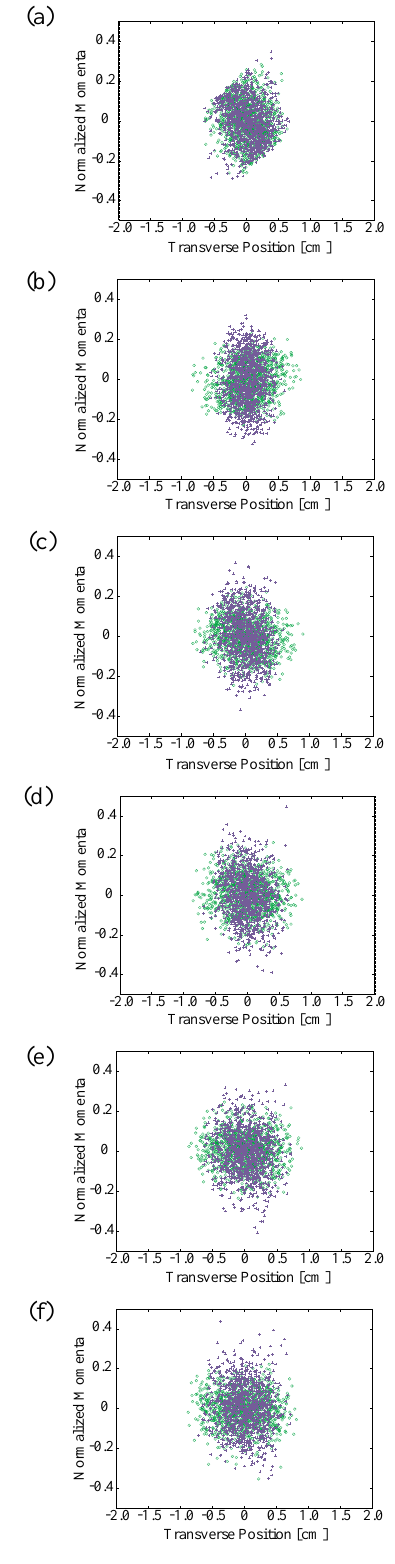
FIG. 12. (Color) Transverse phase-space distributions (horizon- tal: green diamonds; vertical: blue crosses) of the microbunch after passing through cavities #1 (a), #5 (b), #10 (c), #15 (d), #25 (e), and #35